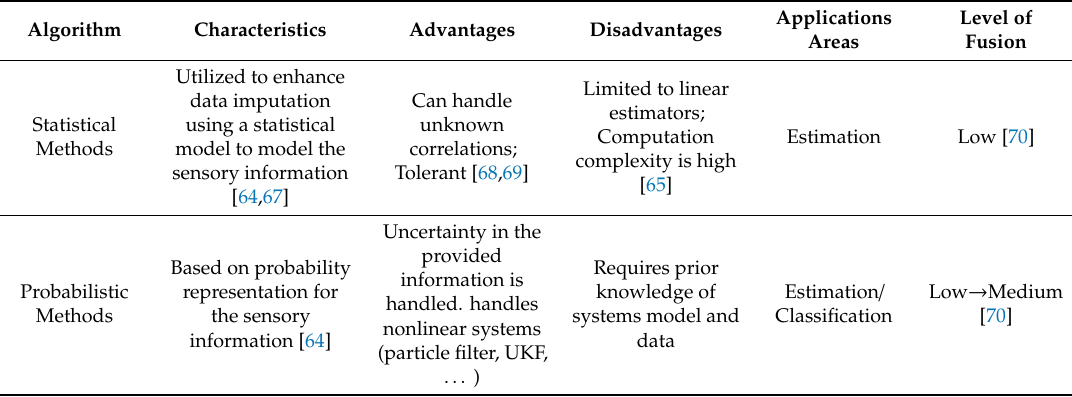
Table 2. A comparison between traditional sensor fusion algorithms, their advantages, disadvantages, applications, and fusion